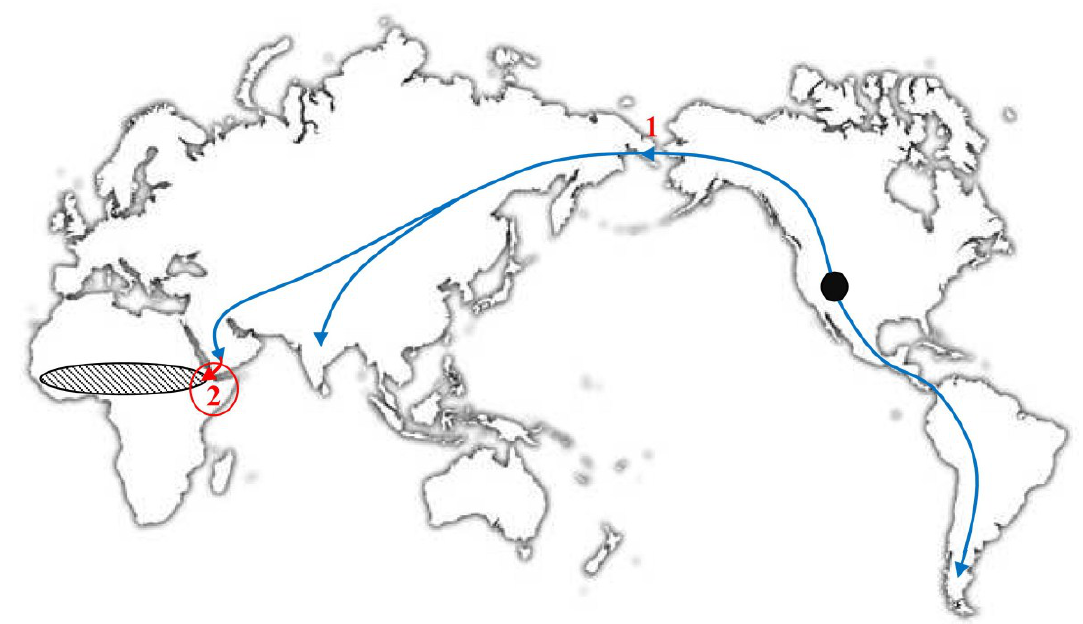
Figure 3. World map. The Black circle denotes the putative region of the origin of the camelid ( Camelidae ) ancestors approximately 45 MYA [60]. The direction of their migration is shown with arrows: 1, migration of the camel ancestors from North America to Asia 2–3 MYA [61]; and 2, introduction of domesticated camels into East Africa approximately 4 TYA [55,56]; hatched oval: the distribution area of naked sole gerbils [53,54]. Legend and figure reproduced from